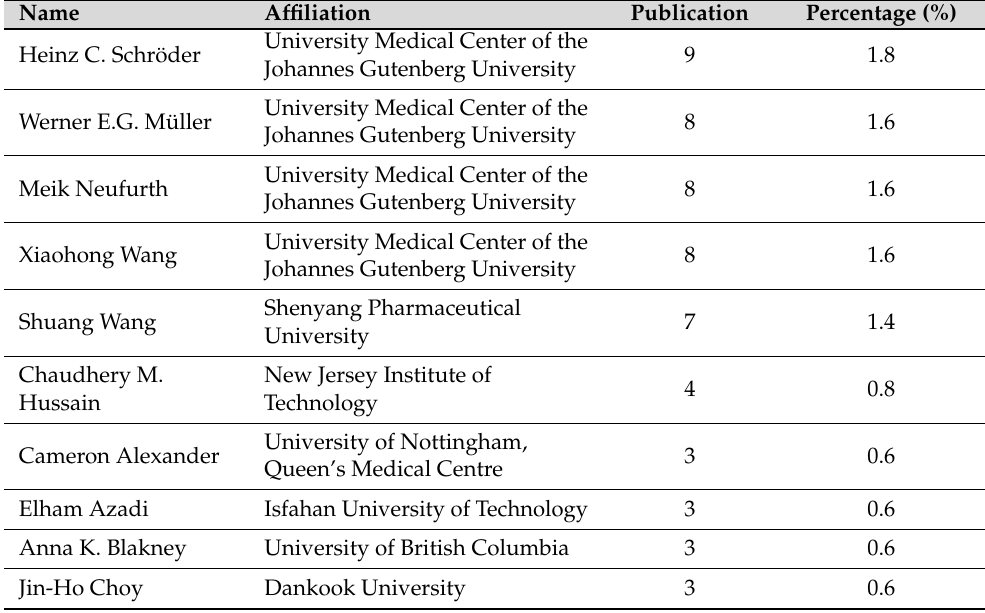
Table 3. Top 10 authors of polymer research related to